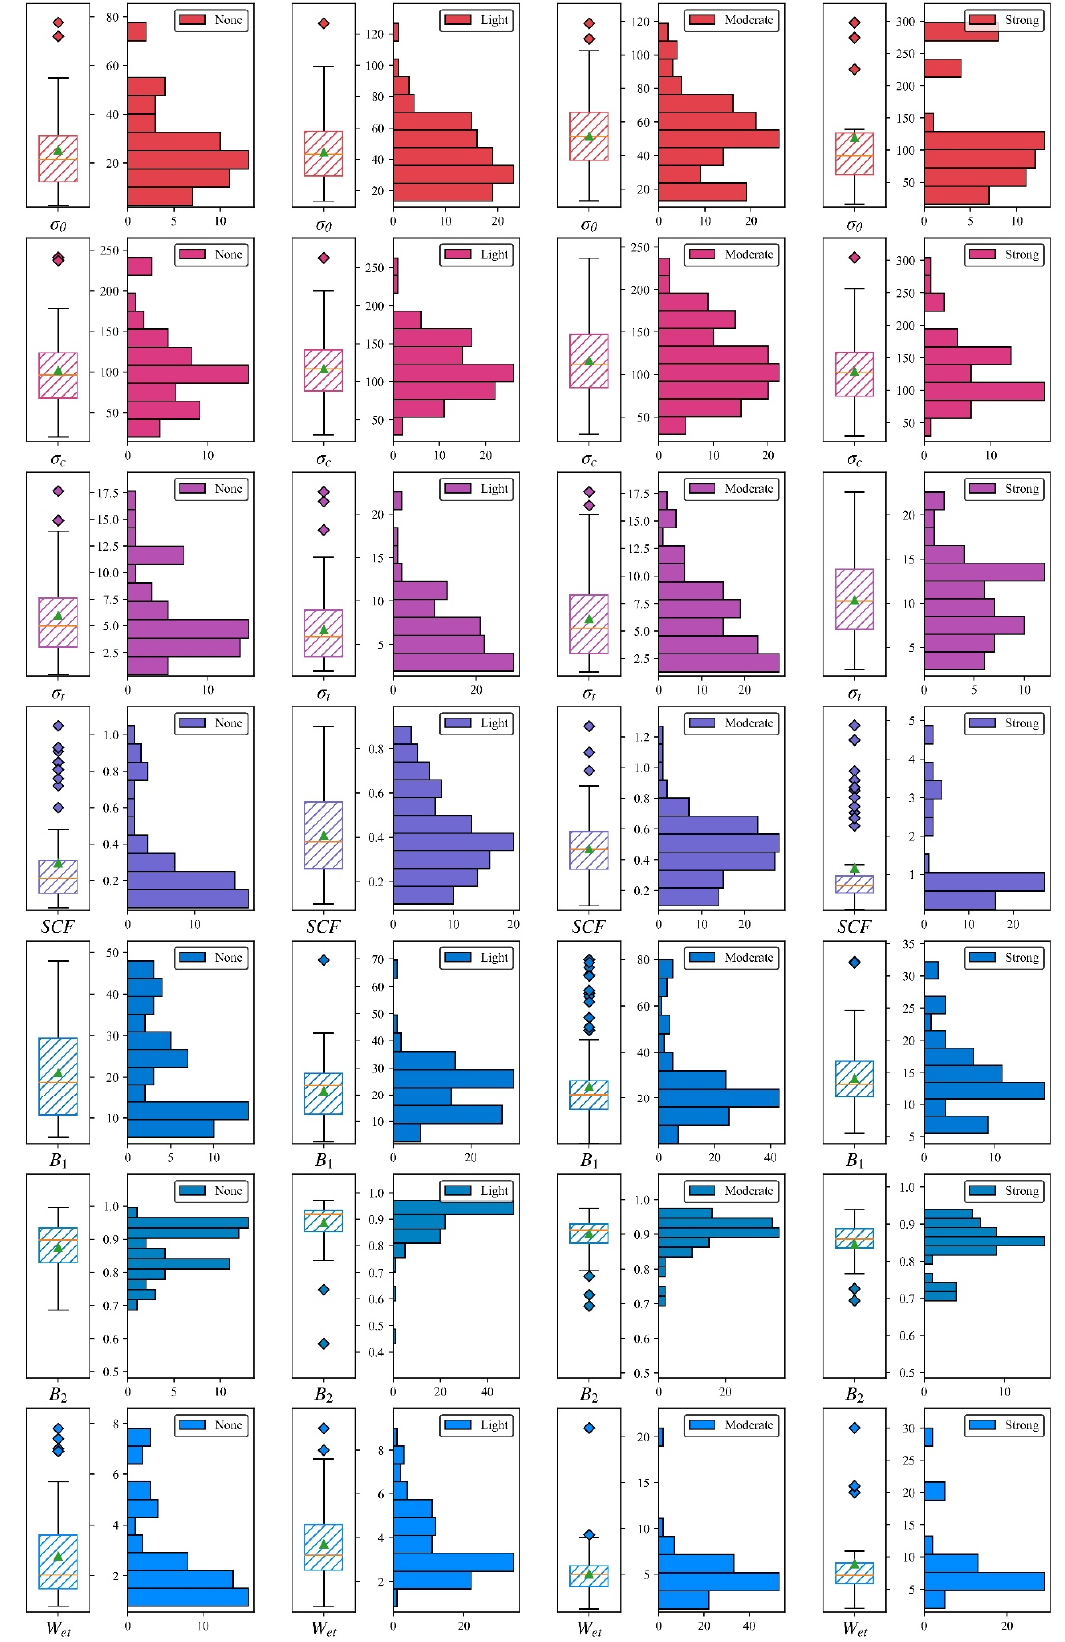
Figure 4. Boxplots and histograms of the seven variables of four rockburst intensities.